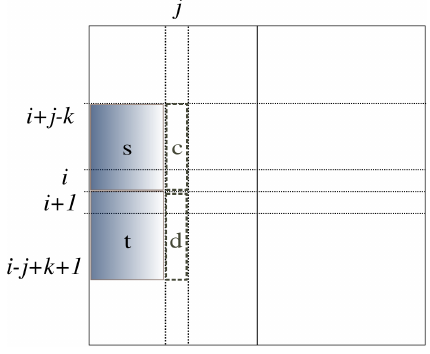
Figure 5. Illustration for Algorithm